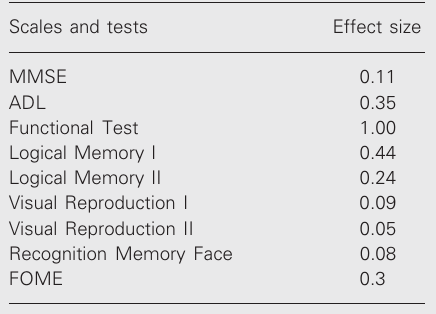
Table 4. Effect size of treatment of patients with Alzheimer´s disease determined with some scales and